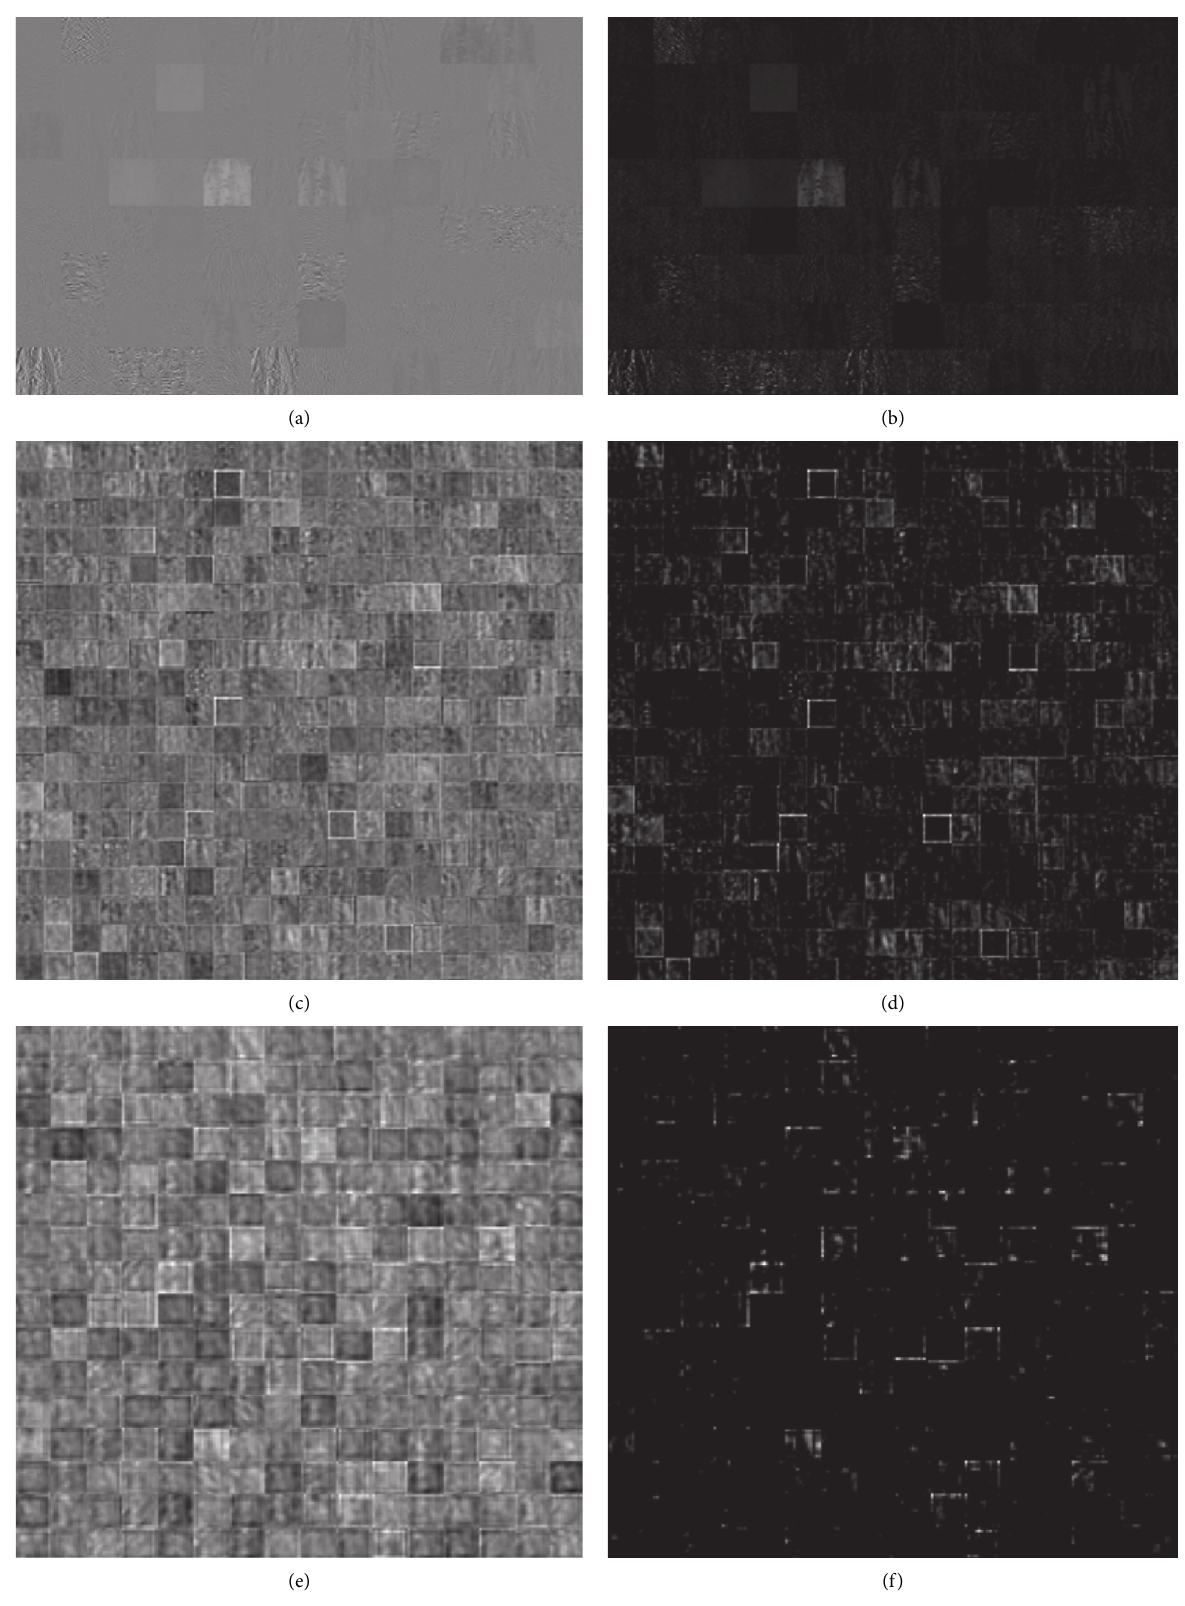
Figure 8: Feature extraction results of different Conv and ReLu for mud pavement images. (a) Conv1. (b) ReLu1. (c) Conv3. (d) ReLu3. (e) Conv5. (f)